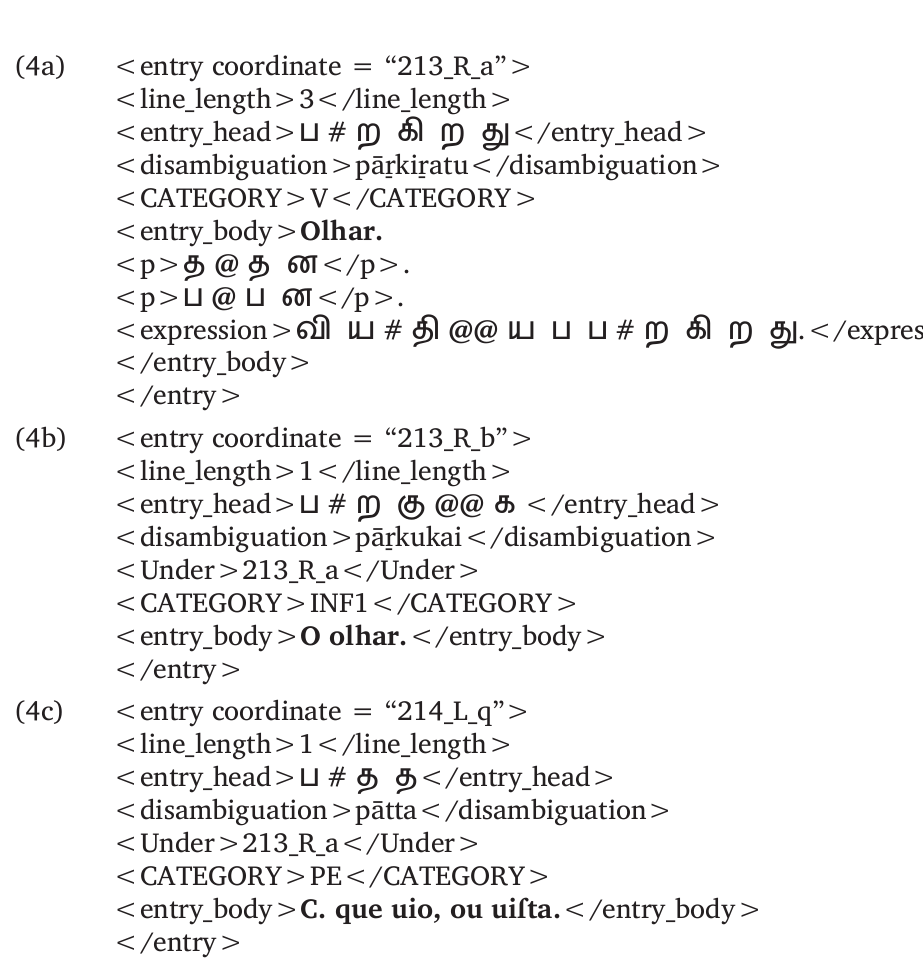
Figure 9: Entry 214_L_q in the 1679